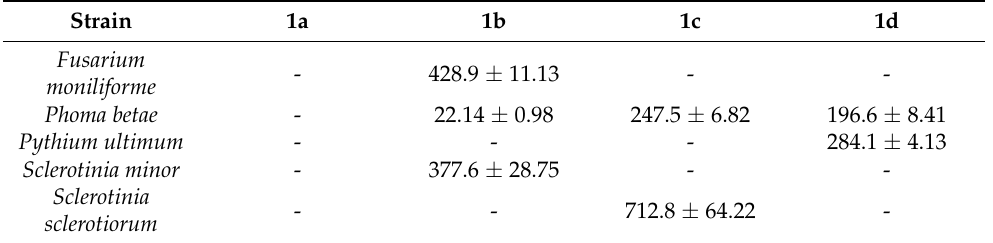
Table 4. IC 50 values of bile acids for selected fungi expressed in µ g/mL.